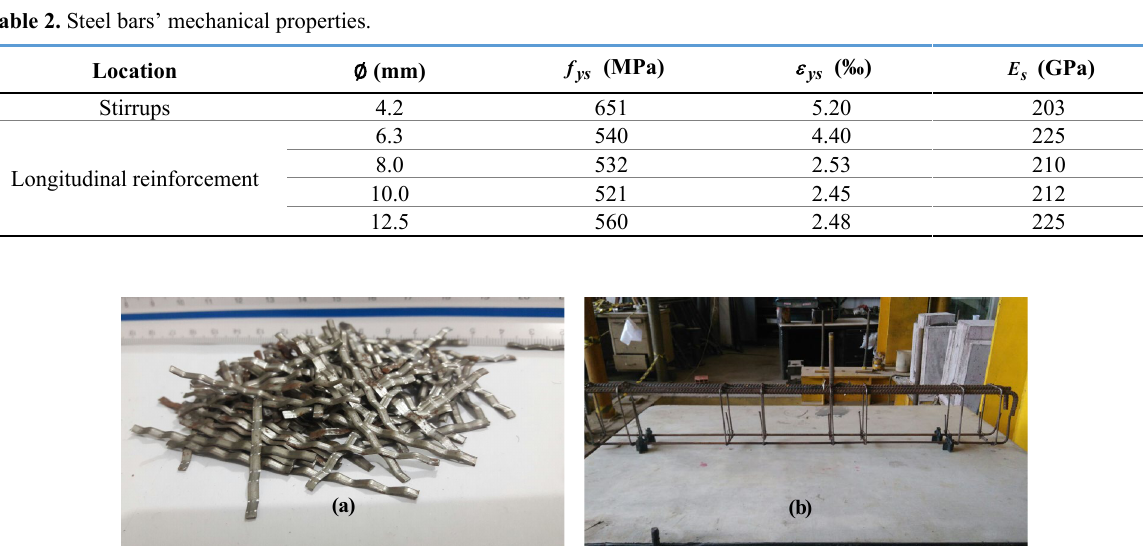
Figure 2. (a) Flat crimped steel fiber [1] and (b) Reinforcing steel